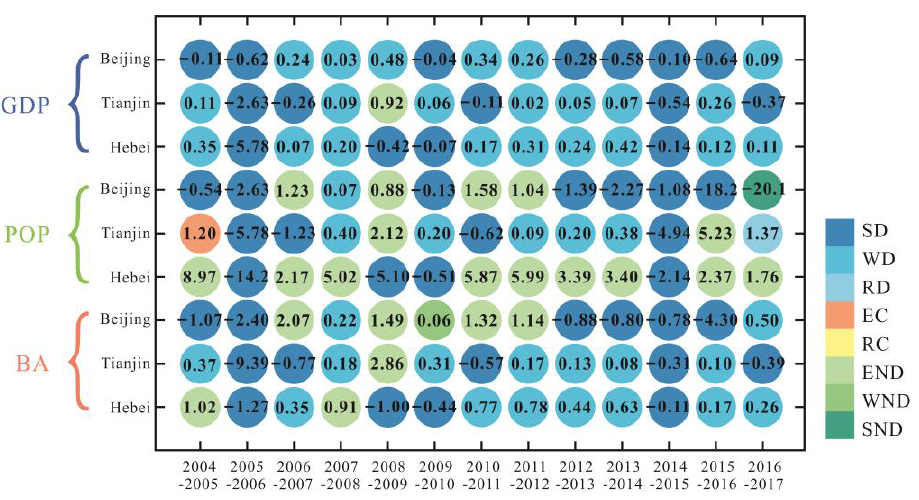
Figure 8. Decoupling state of VWF and GDP (gross domestic product), POP (population), and BA (built-up area) in the BTH region. The value is the decoupling index (D, calculated by Equation (12)). SD: strong decoupling, WD: weak decoupling, RD: recessive decoupling, EC: expansive coupling, RC: recessive decoupling, END: expansive negative decoupling, WND: weak negative decoupling, SND: strong negative decoupling.